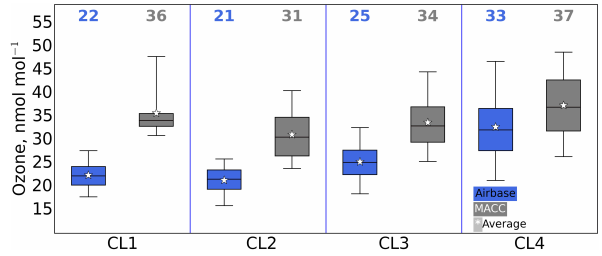
Figure 6. Percentiles (5–25–50–75–95) of ozone means in clusters; Airbase vs. MACC, first CA. Upper values indicate the mean of each cluster.